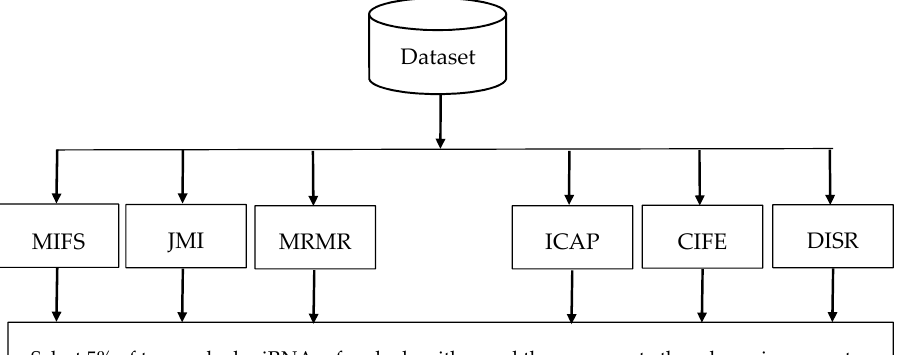
Figure 1. Flowchart of the ensemble of filter algorithms to generate the Micro-Ribonucleic Acids (miRNA) pool.